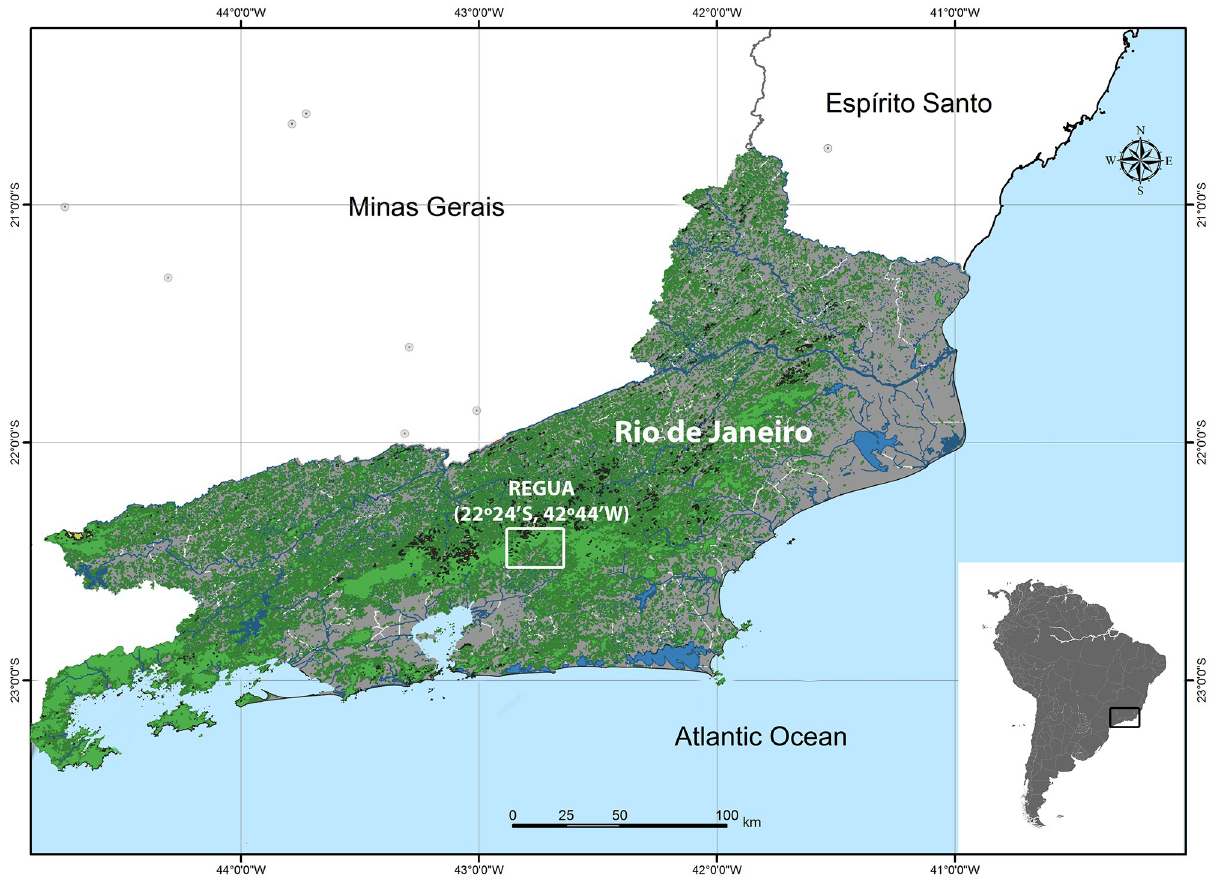
Fig 1. Study site. Map of Rio de Janeiro State, Brazil, showing the Reserva Ecolo´gica de Guapiac¸u´ (REGUA) from which specimens were sampled. Atlantic Rainforest remaining fragments are represented in dark and light green; continental waters in dark blue; urbanized area in gray. The map was made using the QGIS software with shapefiles from the IBGE Database